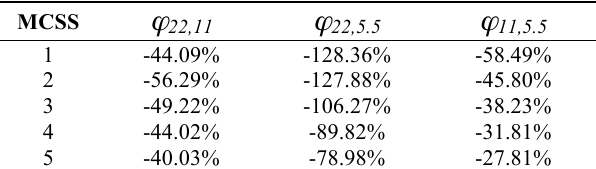
Table 8. Change in Average CPD in Mesh Fields When Decreasing Communications Range